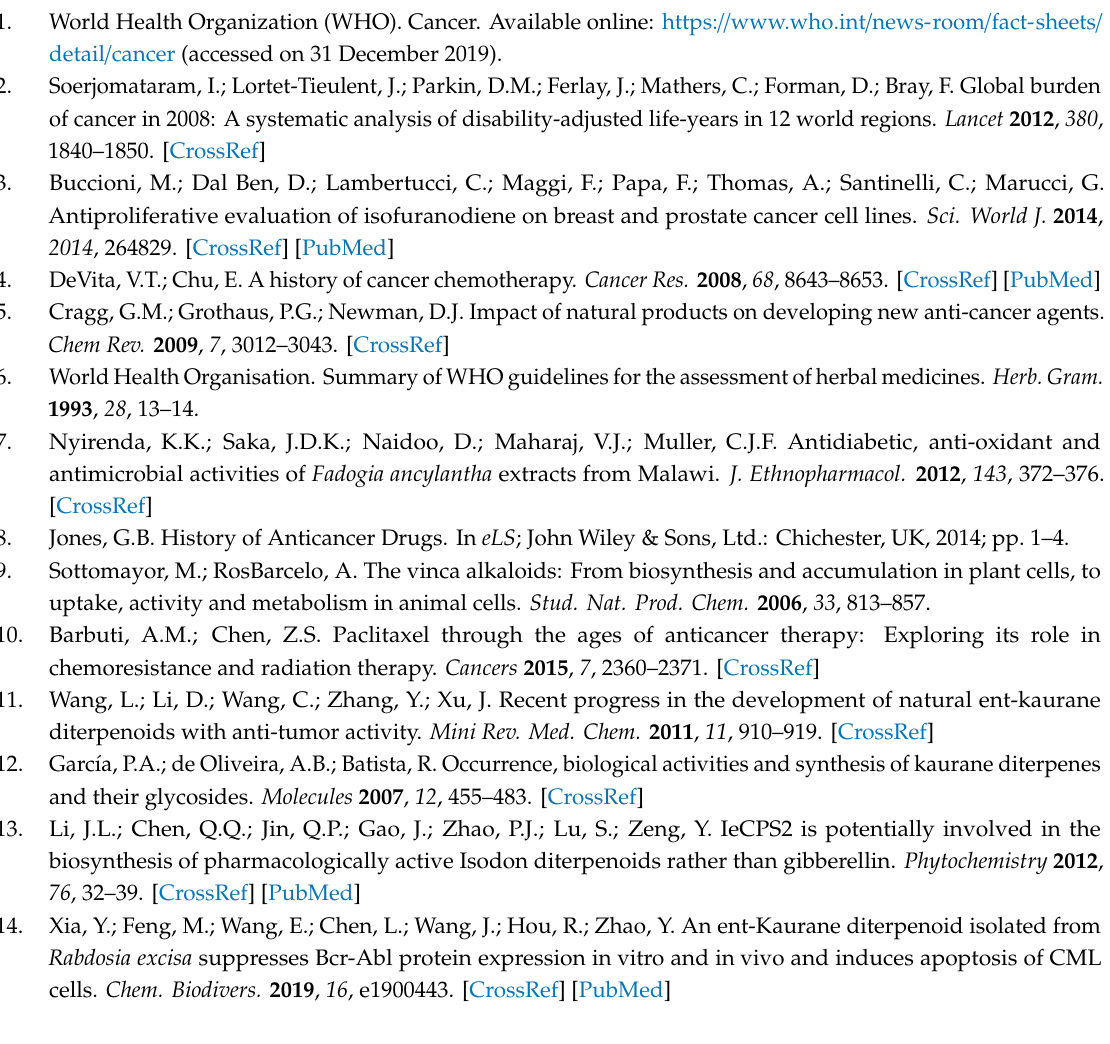
Table S1: Plant-derived anticancer ent -kaurane diterpenoids with their biological